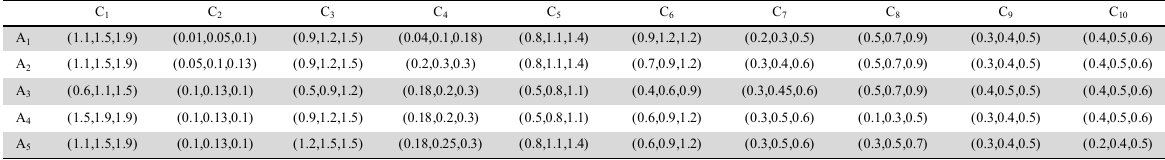
Weighted fuzzy decision matrix